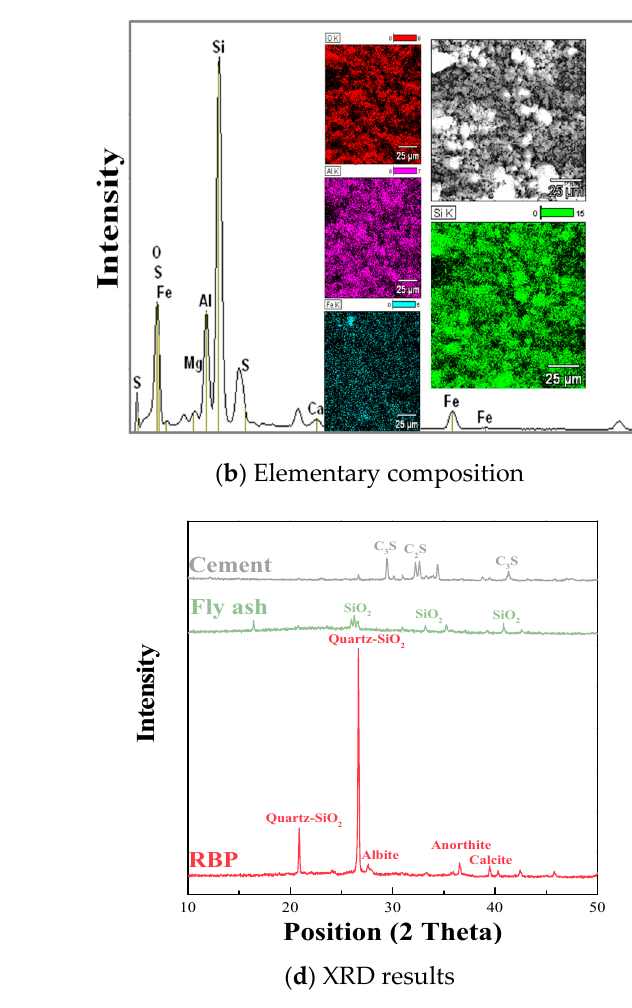
Figure 3. Particle size and mineral component of RBP and cement.